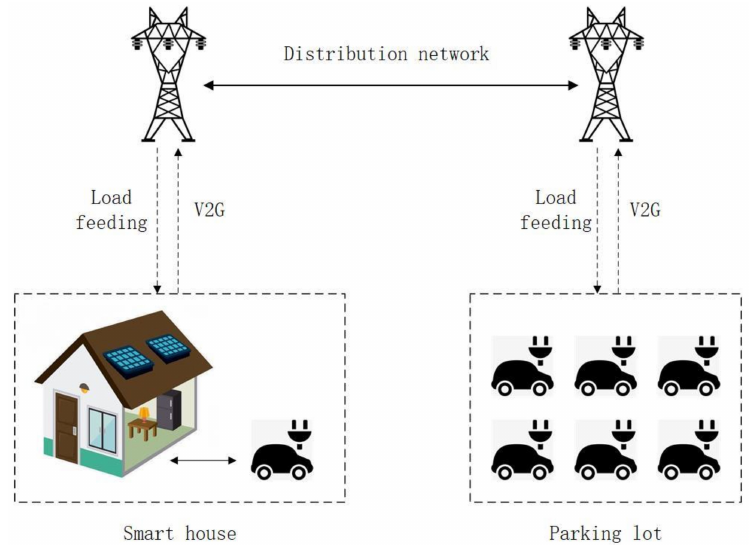
Figure 11. Framework for vehicle-to-grid (V2G)